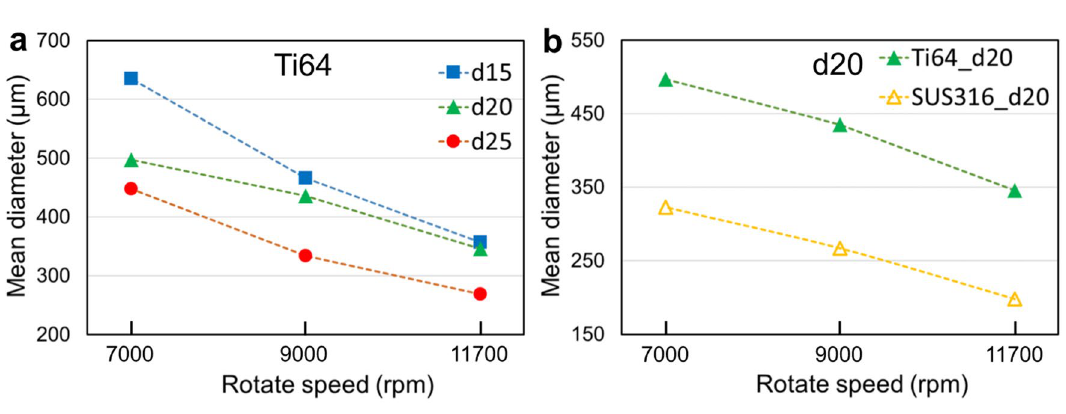
Figure 1. SEM images of the PREP-produced Ti64 and SUS316 powders under varying rotating speeds and electrode diameters. The arc current applied here was 80 A.